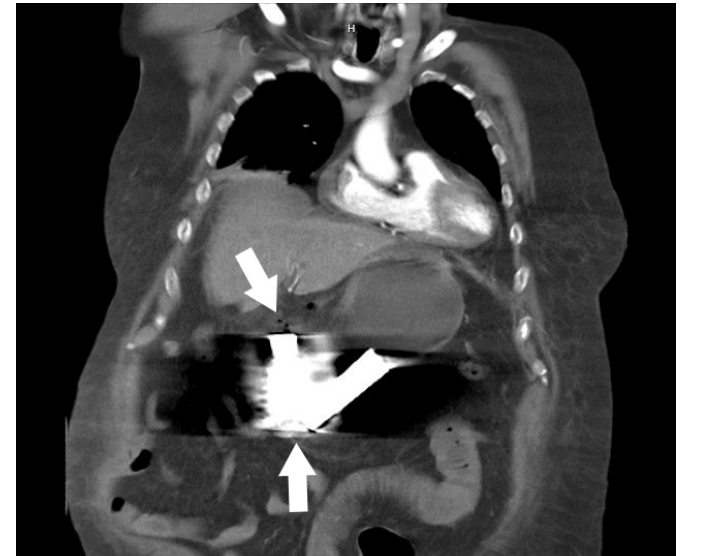
Image 2. Computed tomography of the abdomen and pelvis demonstrating foreign bodies that appear to be in the stomach with extensive artifact due to metallic foreign bodies. Bottom arrow points to two foreign bodies, which were reported to be two AA batteries per the patient. Top arrow points to free air within the peritoneum suggesting hollow viscus perforation.